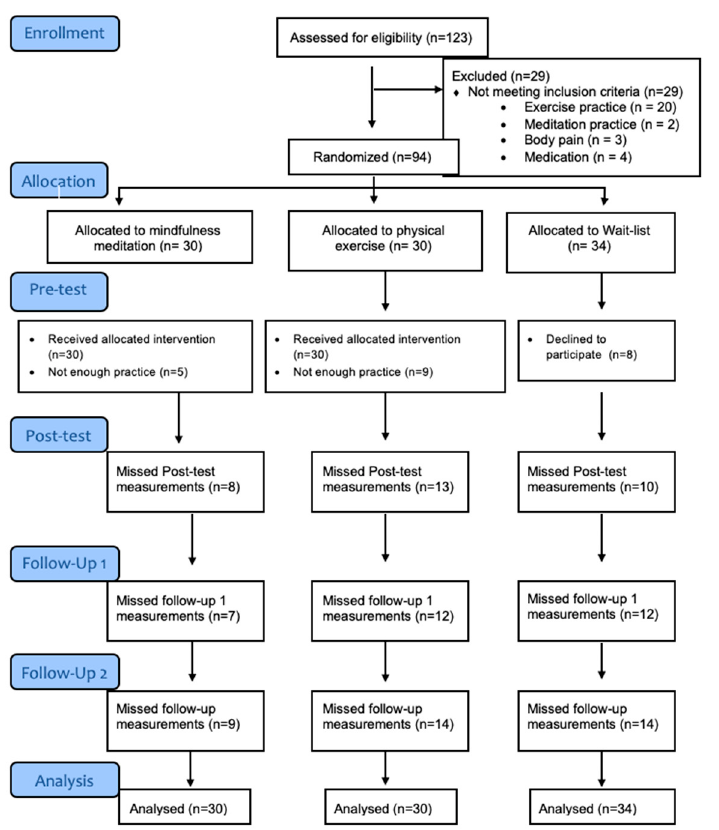
Figure 1. Consolidated Standards of Reporting Trial (CONSORT) diagram for a Randomized Controlled Trial of mindfulness meditation, physical exercise and control group.